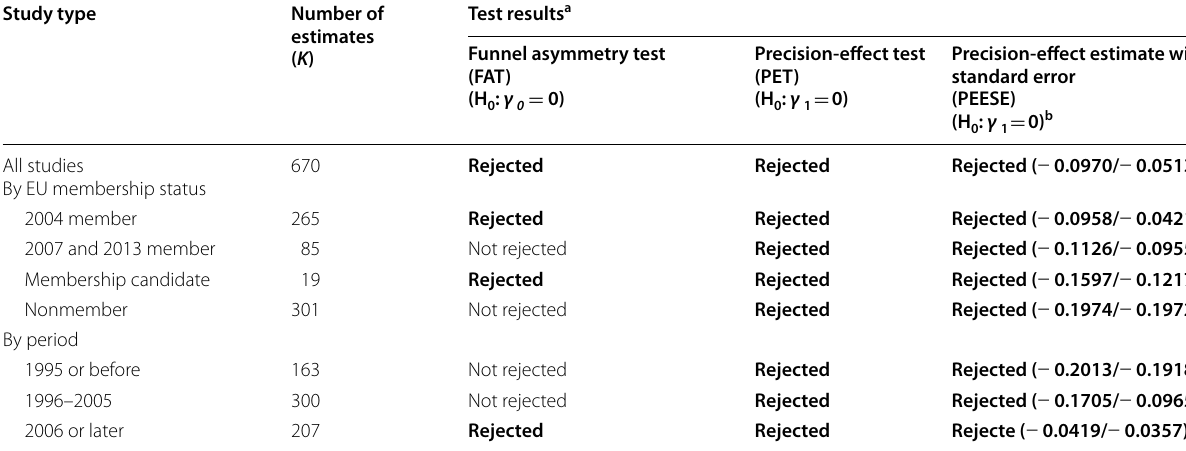
Table 8 Summary of publication selection bias